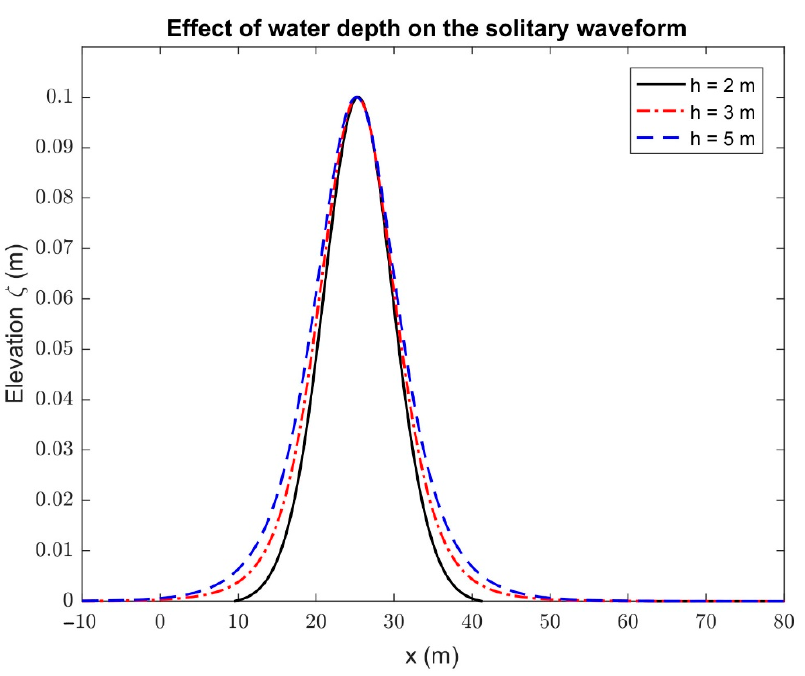
Figure 20. Effect of water depth on the solitary wave profiles in the outer region versus water plane length x (m).